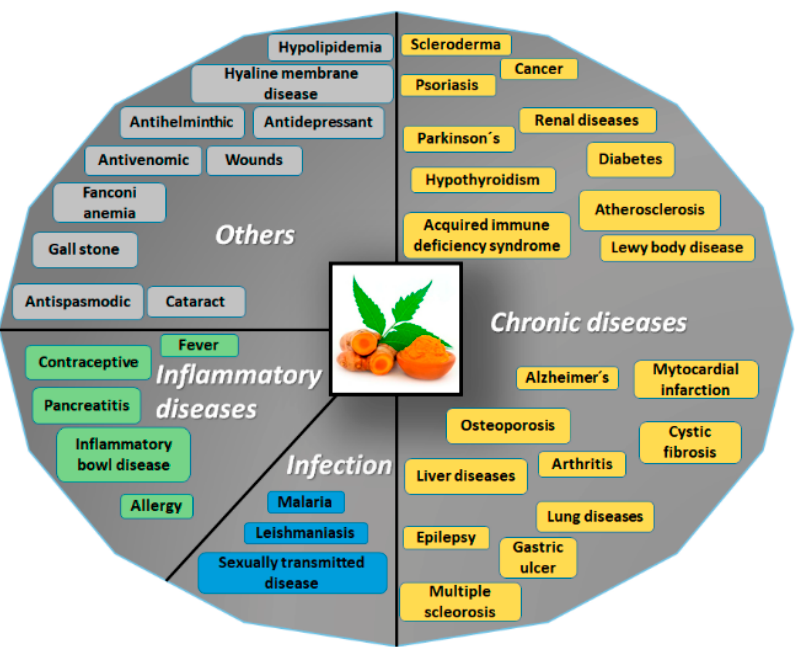
Figure 6. Potential applications of curcumin. Due to the structure of curcumin, this molecule could be applied as treatment for a wide range of disorders, such as chronic diseases, inflammatory disorders, infections of diverse etiology, and other conditions. Adapted with permission from [26]. 2007, Springer Nature.